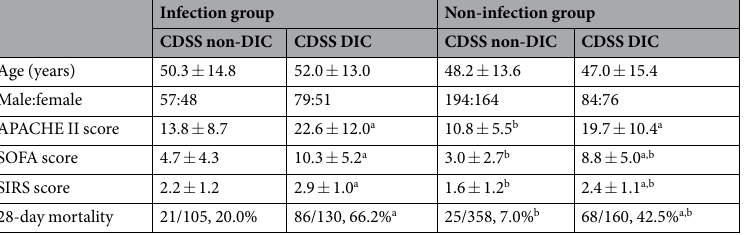
Table 2. Baseline characteristics of the patients. DIC, disseminated intravascular coagulation; CDSS, Chinese DIC Scoring System; JMHW, Japanese Ministry of Health and Welfare; ISTH, International Society on Thrombosis and Haemostasis; JAAM, Japanese Association for Acute Medicine; APACHE, Acute Physiology and Chronic Health Evaluation; SOFA, Sequential Organ Failure Assessment; SIRS, systemic inflammation response syndrome. a p < 0.05 between CDSS DIC and CDSS non-DIC; b p < 0.05 between infection and non- infection.